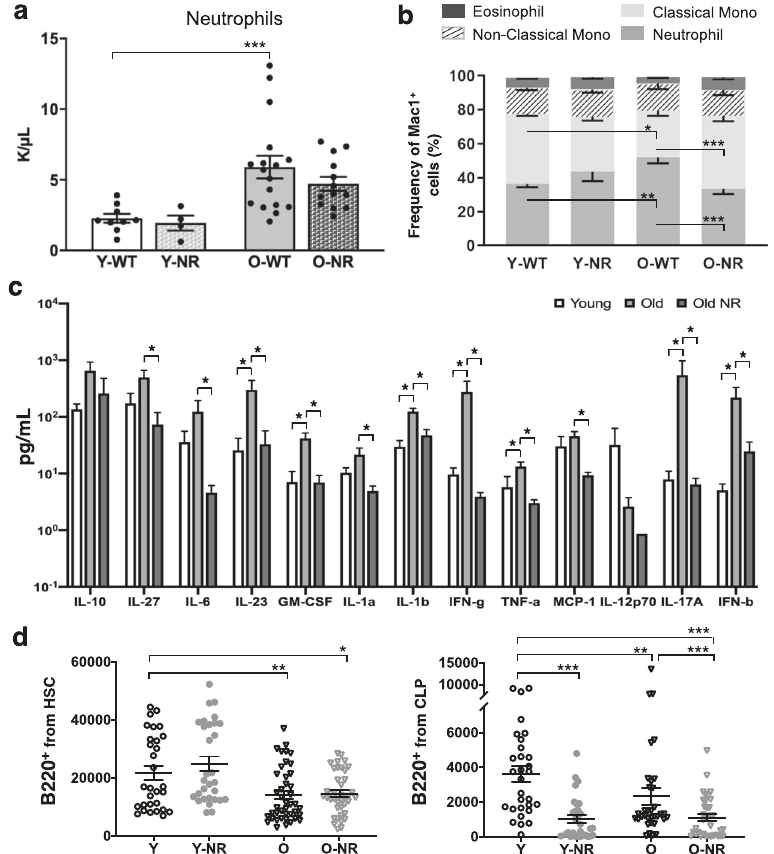
Fig. 3 NR treatment reduces in fl ammation in old WT mice. a Complete blood cell count data from four experimental groups shows differences in neutrophils ( n = 4 – 17). b Composition of Mac1 + cells from peripheral blood ( n = 4 – 17). c Serum cytokine levels from young, old, and NR-treated old mice were evaluated with LEGENDplex TM mouse in fl ammation panel ( n = 6 – 7). d B220 + cells derived ex vivo from HSCs and CLPs. Data are represented as mean ± SEM. Kruskal – Wallis test for a , c , and d , two-way ANOVA for b . q value (Kruskal – Wallis test) or p value (two-way ANOVA): <0.05*, <0.01**,